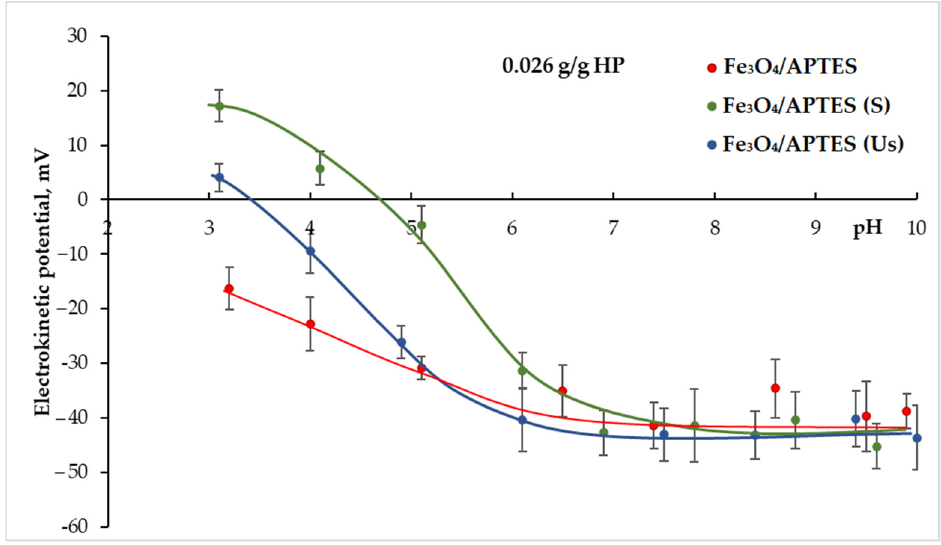
Figure 3. Effect of humic preparation (0.026 g/g) adsorption on the pH-dependent zeta potential of samples ± standard deviation.